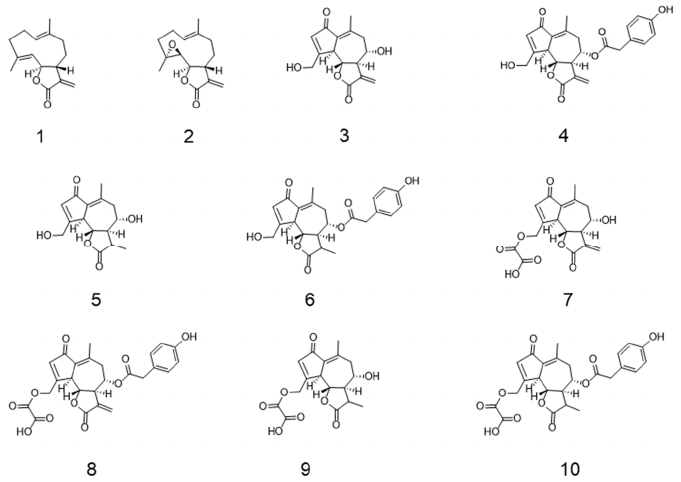
Figure 1. Chemical structure of tested sesquiterpene lactones (SLs). ( 1 ) Costunolide; ( 2 ) parthenolide;